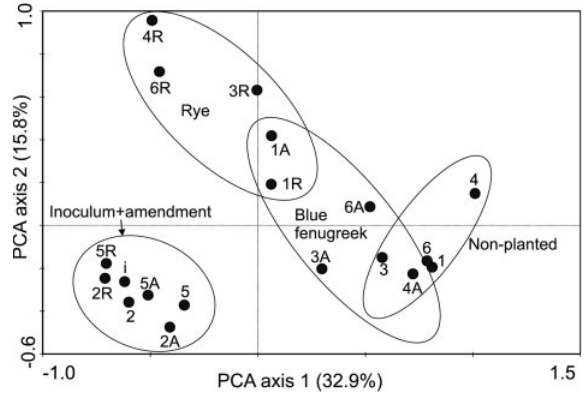
Fig. 2. Grouping of soil samples based on principal compo- nent analysis of the48 h substrate utilization patterns obtained with Biolog EcoPlates. Sample codes are given in Table